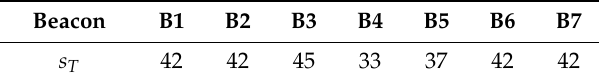
Table 4. Principal configuration of the tests carried out and their main objectives.